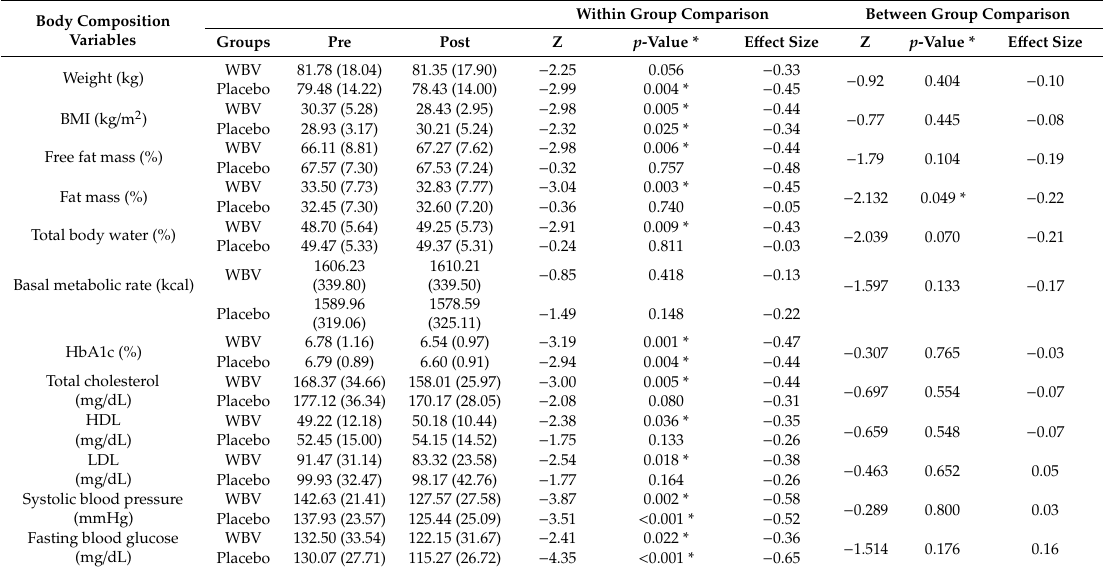
Table 3. Intent-to-treat of 8-weeks WBV training in the body composition, blood pressure, lipid profile, blood glucose, and